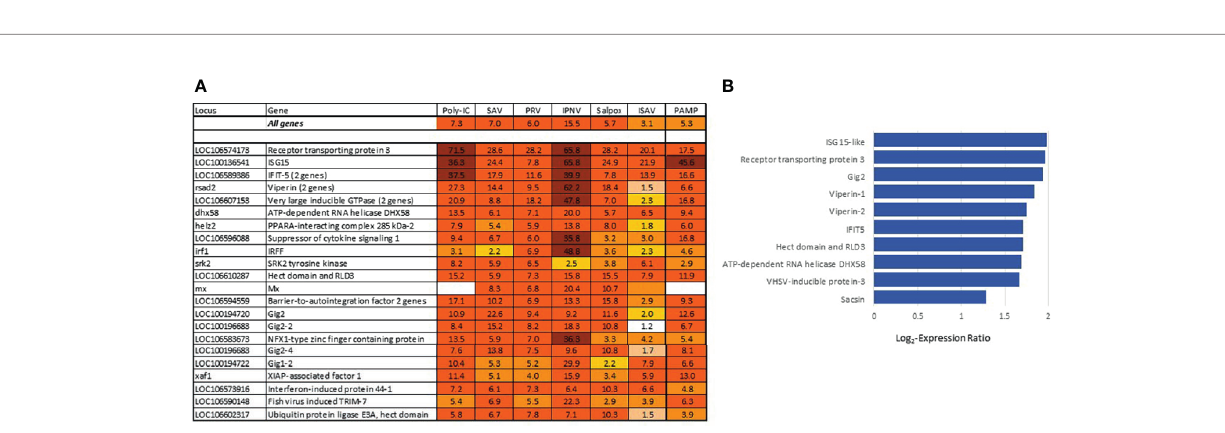
FIGURE 3 | (A) Genes with the strongest antiviral responses. Here and in subsequent heat maps, data are the mean folds to intact controls. Information on tissues, cells and time-points is in Table 1 . For each virus and poly(I:C) all data (contrasts) were averaged. (B) highly ranked VRG with preferential expression in erythrocytes (microarray data), log 2 -Expression Ratios to means of nine tissues and cell